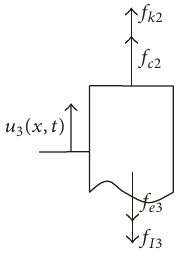
Figure 7: Force analysis of the upper end of perforation